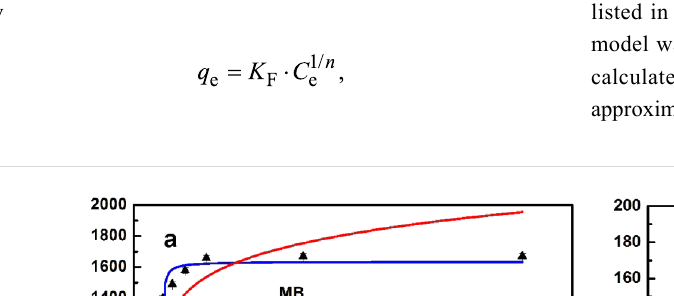
and the Freundlich isothermal linear expression is